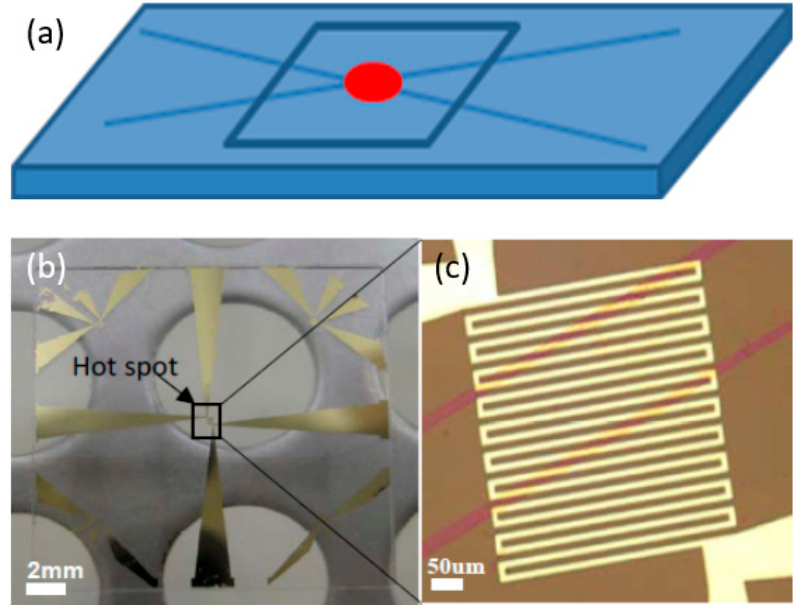
Figure 14. The hotspot test structure with the hexagonal boron nitride (hBN) heat spreader film. Reprinted with permission from [46].